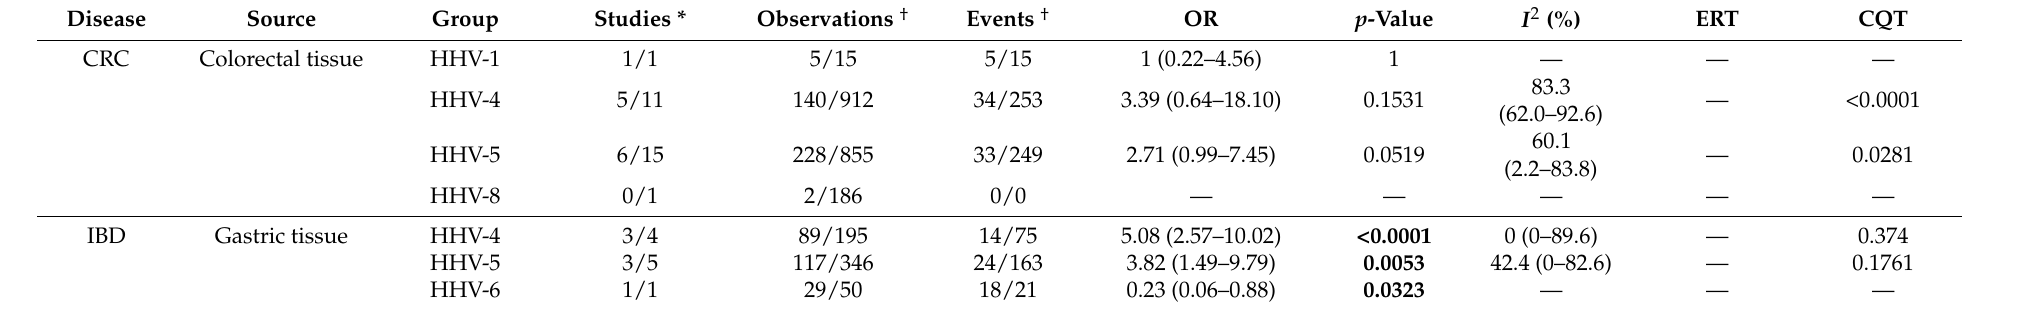
Table 3. Mixed-affect model for the risk of CRC, and IBD, predicted by the studies related to an infection with Herpesviruses. The studies are stratified by specimen type (Source) and Herpesvirus genotype (Group). The ORs are reported with their 95% confidence interval and p -value. I 2 = Higgins index; ERT = Egger’s regression test; CQT = Cochran’s Q